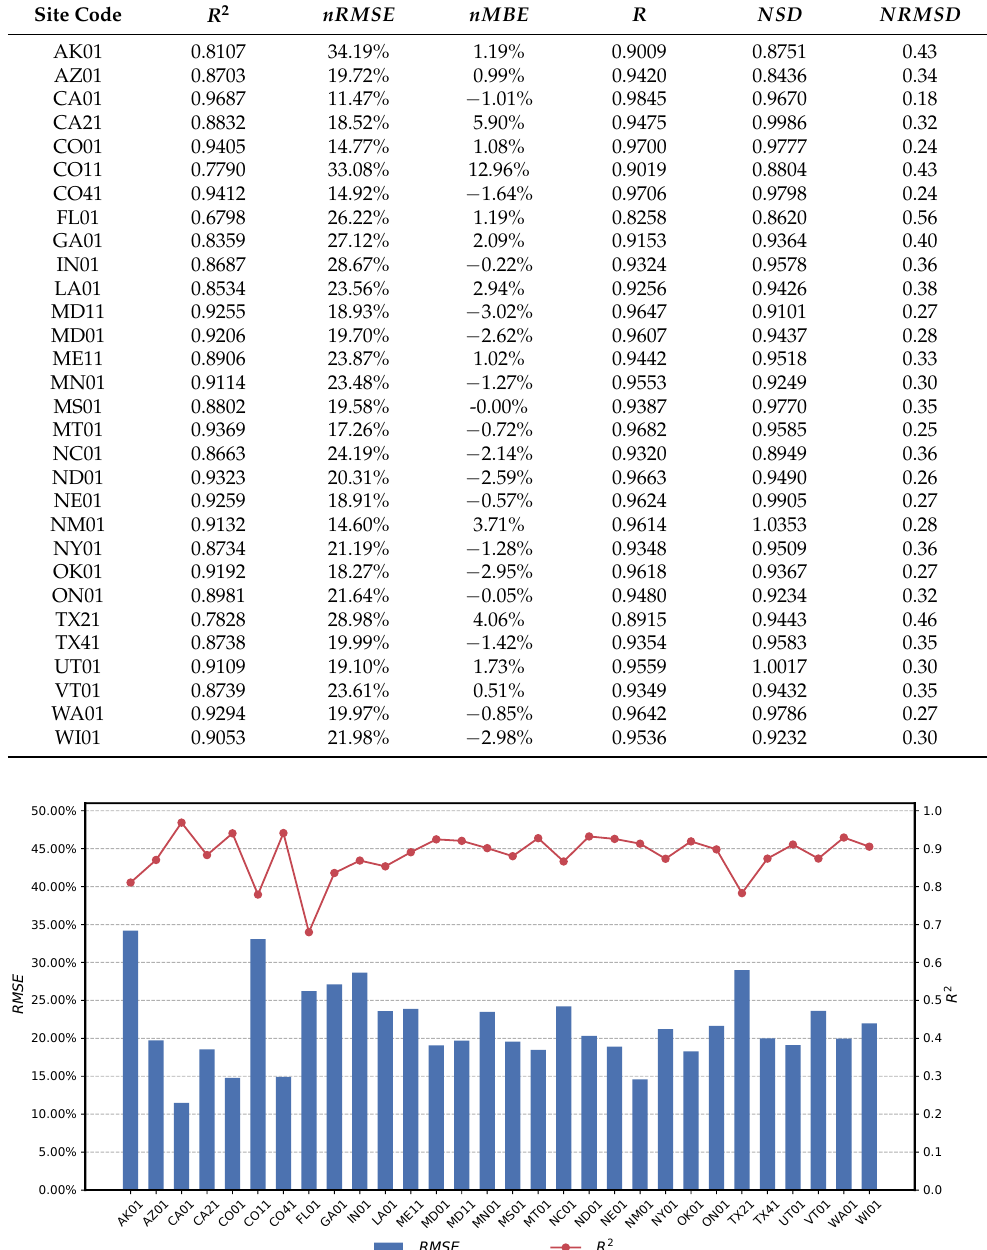
Figure 11. Performance evaluation of the DRFCN+RF model on the UVMRP dataset by R 2 and nRMSE ( % ) . The nRMSE ( % ) and R 2 are displayed on the left and right axes,